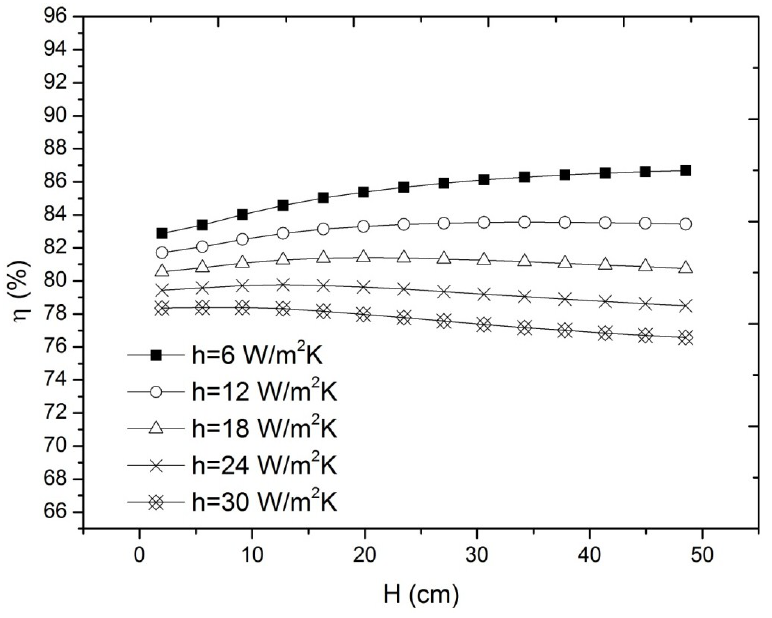
Figure 11. Efficiency varying cavity height (aperture radius = 10.13 cm and receiver radius = 15.98 cm).